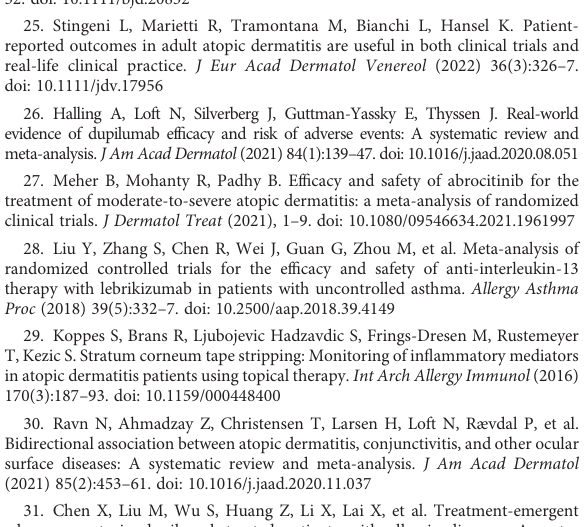
SUPPLEMENTARY FIGURE 1 Assessment of risk bias of RCTs.